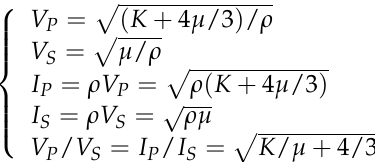
Figure 7. Cross-plots of bulk modulus vs. modulus ratio for core matrices, dry cores, and water- saturated cores. Blue dots are group one, indicating quartz-rich cores; green dots are group two, indicating boehmite-rich cores; and red dots are group three, indicating clay-rich cores. Transform- ing among states, the groups vary following pore embedding (PE) and fluid replacement (FR) trends.